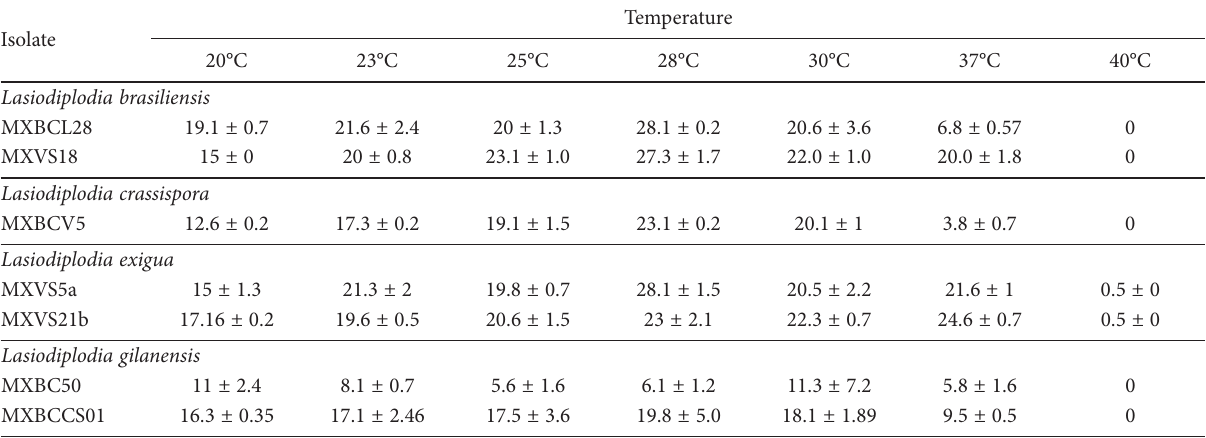
Table 3. Mean colony diameters at different temperatures for Mexican Lasiodiplodia isolates grown in PDA cultures.